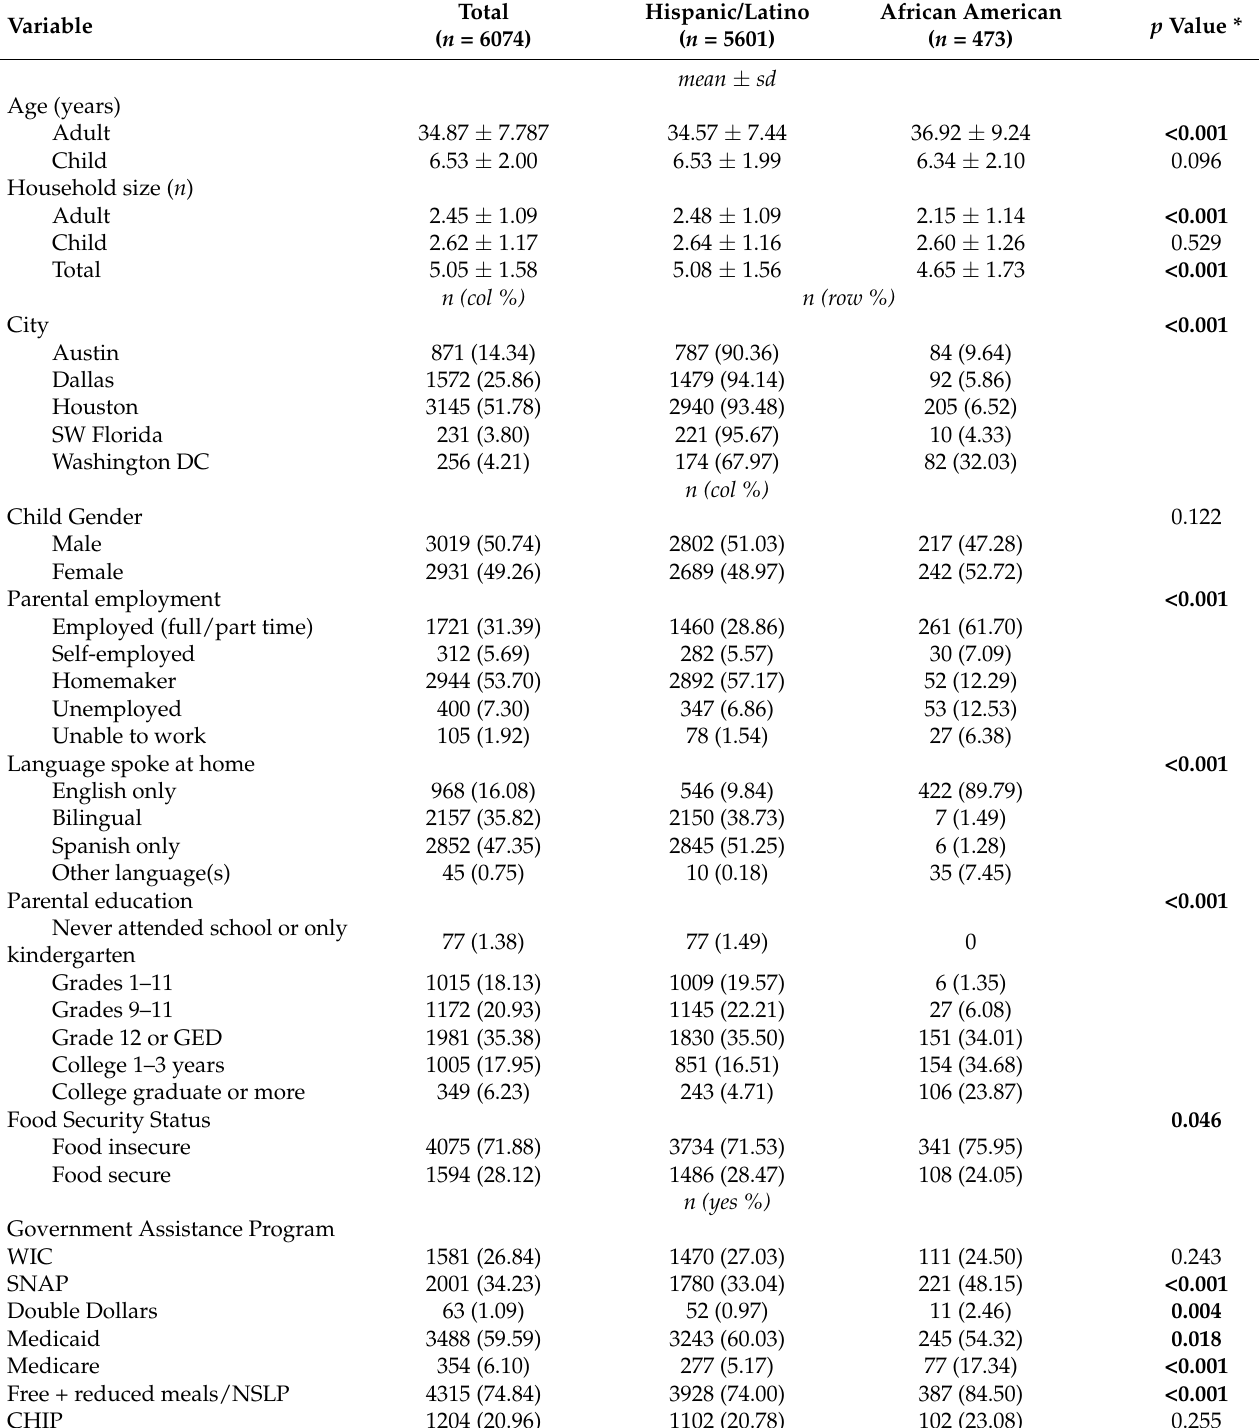
Table 1. Demographic Characteristics of Brighter Bites Participants ( n = 6074) Stratified by Race/Ethnicity, Fall 2018 Parent Survey at